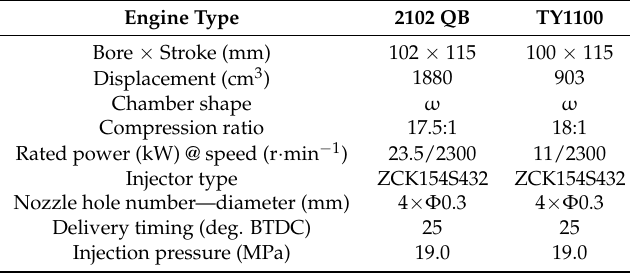
Table 2. Single and Twine cylinder diesel engine